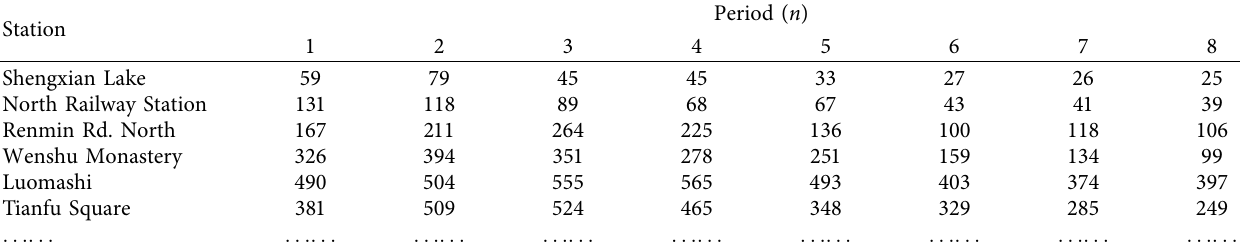
Table 4: Passenger outflows (persons) at stations of line 1 (in part).